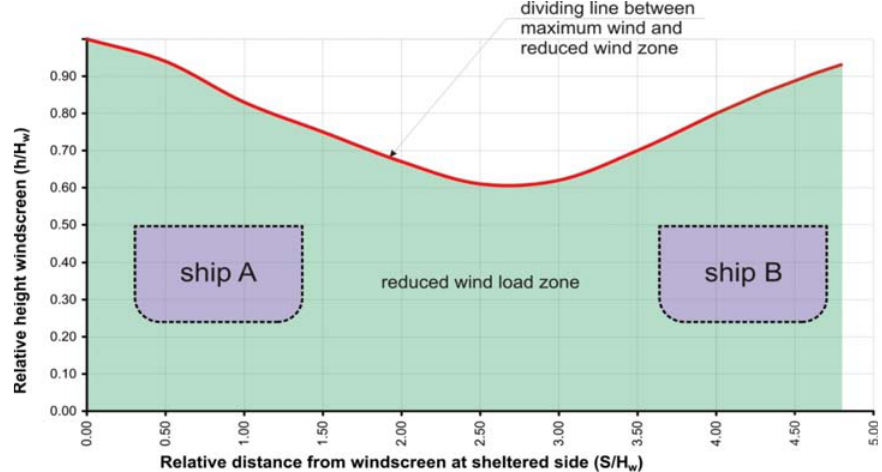
Fig. 14. Locations of berths at the sheltered/lee side of the